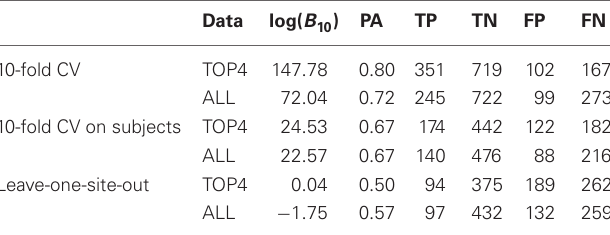
Table 4 | Single source 10-fold cross-validation on subjects. Data